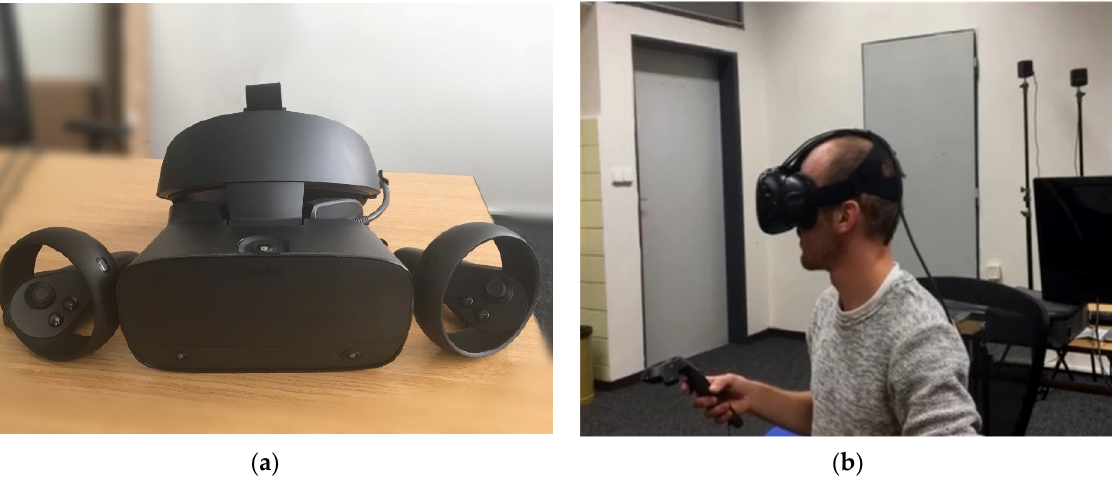
Figure 11. ( a ) Photo of most-used VR headset—Oculus Rift S; ( b ) Vojt ě ch Cehák wearing a VR headset.